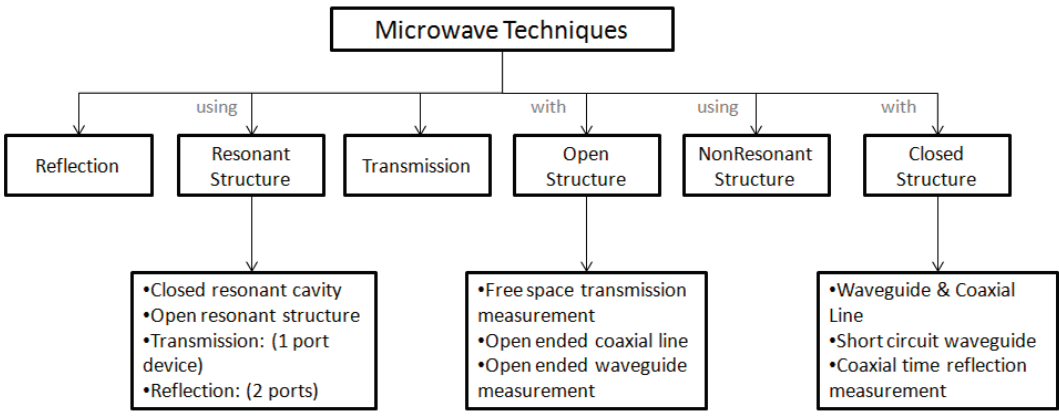
Figure 2. Dielectric property measurement techniques.